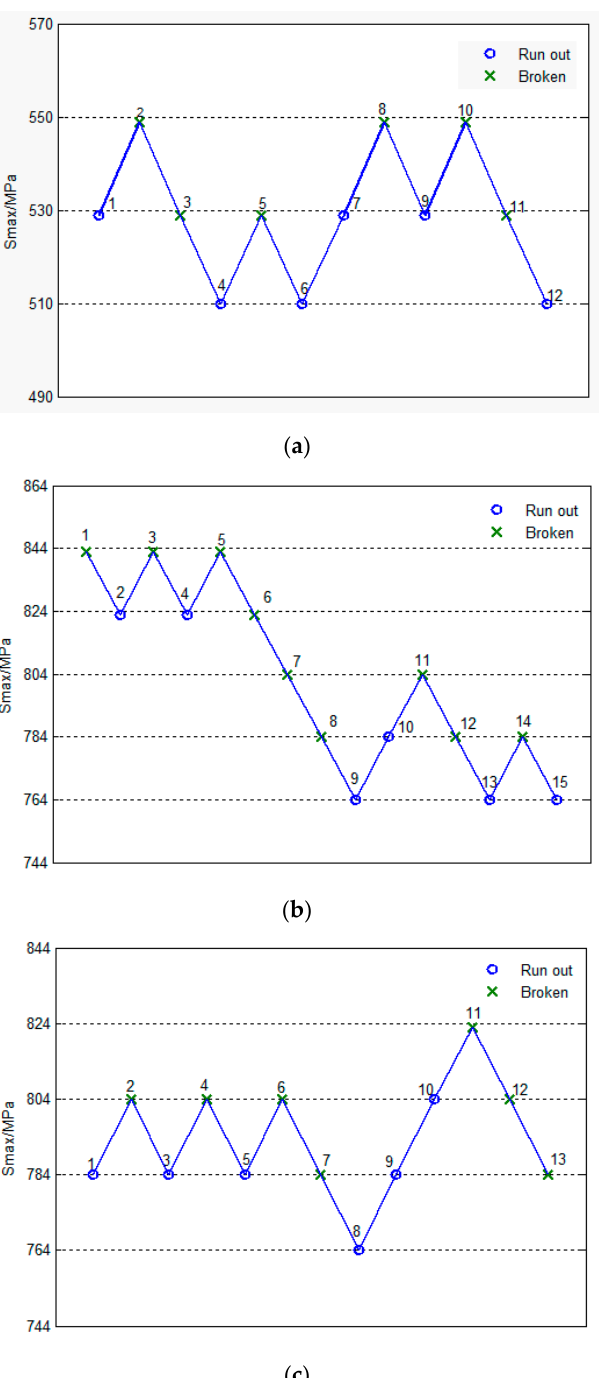
Figure 5. The up-and-down map of fatigue tests ( a ) un-surface treatment specimens; ( b ) shot peened specimens; ( c ) nitrided specimens.